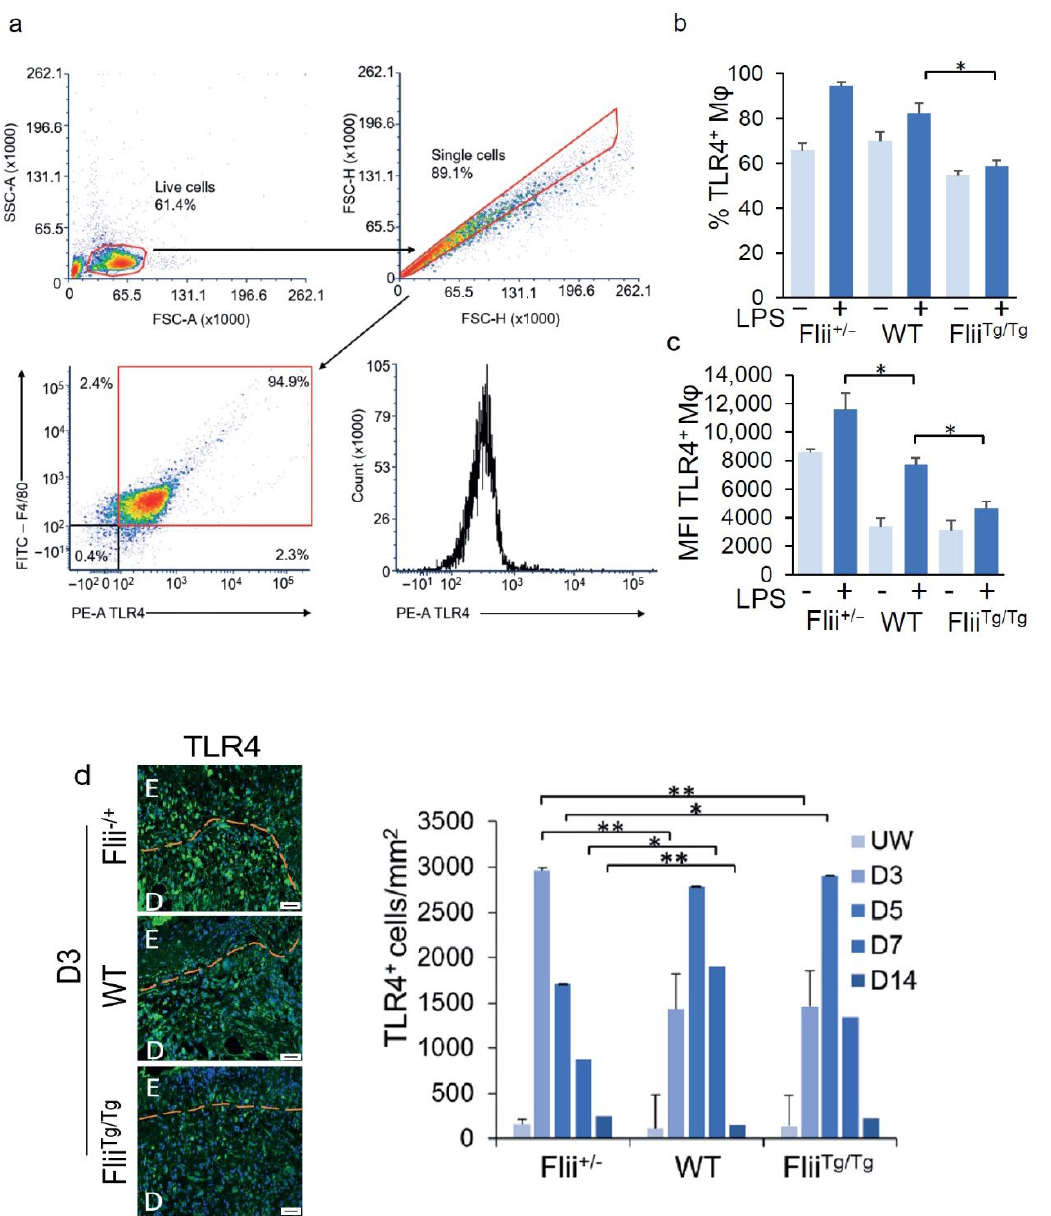
Figure 1. TLR4 expression levels in murine macrophages and wounds from three Flii genotypes (Flii +/ − , WT, and Flii Tg/Tg ): ( a ) Representative gating strategy for macrophage TLR4 expression; Flow cytometry analysis showing ( b ) percentage and ( c ) mean fluorescent intensity of TLR4 + murine macrophages from the 3 Flii genotypes, with and without LPS stimulation ( n = 6); ( d ) Representative images and bar graph showing the number of TLR4 + cells within acute murine wounds of the three Flii genotypes after 3, 5, 7, and 14 days ( n = 6). Scale bars = 50 µm. Results are expressed as mean + /− SEM. * p < 0.05 and ** p < 0.05.